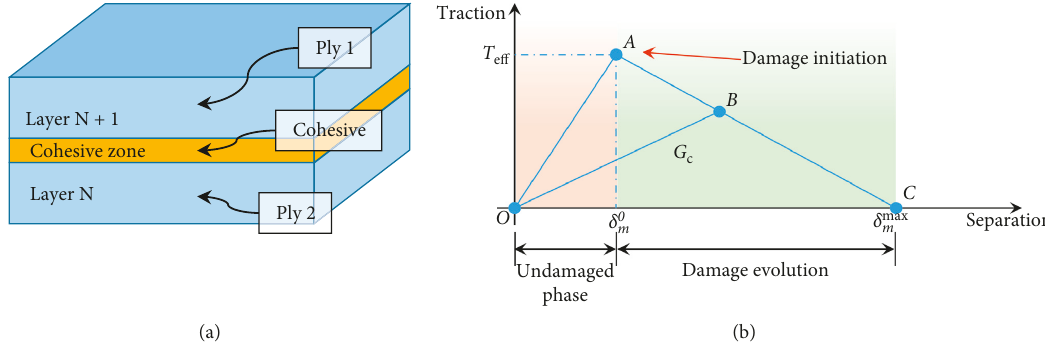
Figure 1: (a) Location of the cohesive elements between adjacent layers and (b) traction-separation law.